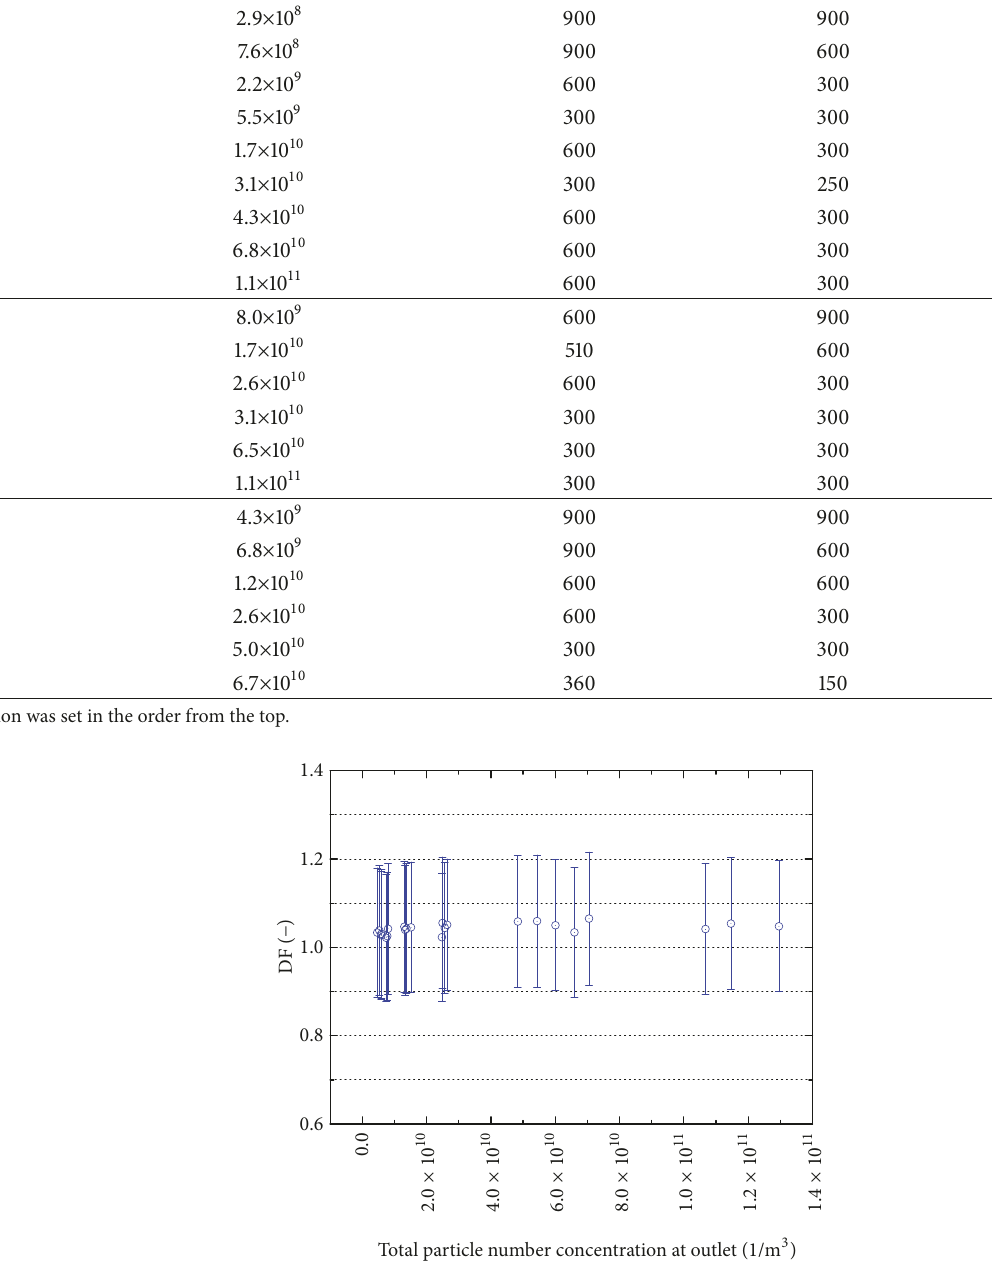
Figure 5: DFs in empty test